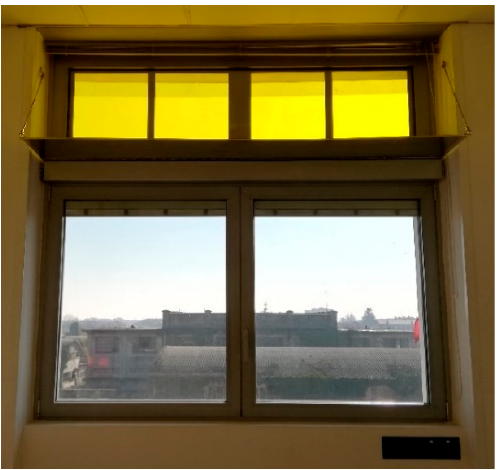
Figure 1. The SW–LSC prototype.